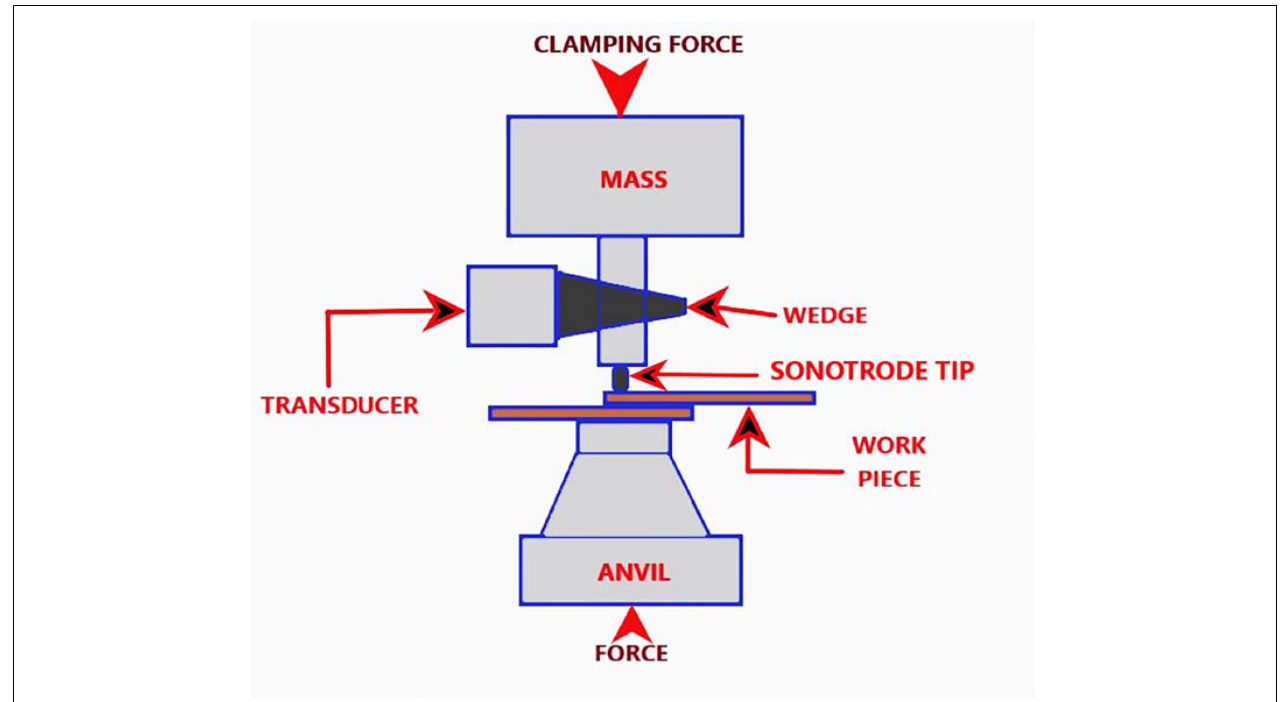
FIGURE 3 | The ultrasonic welding setup.